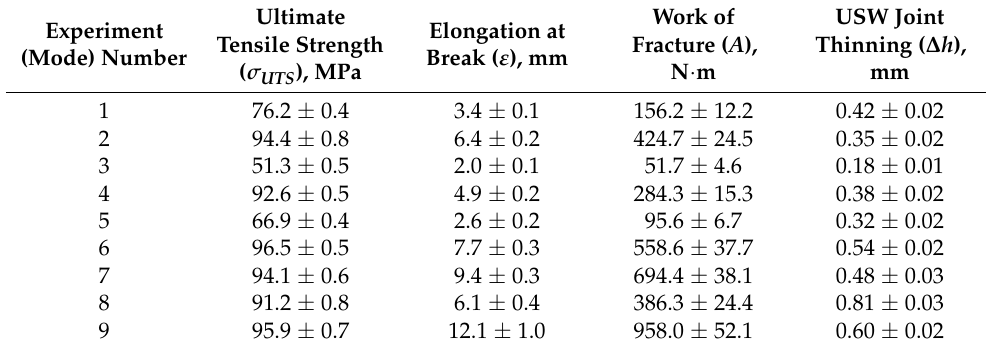
Table 2. Mechanical and structural characteristics of the USW joints for various USW